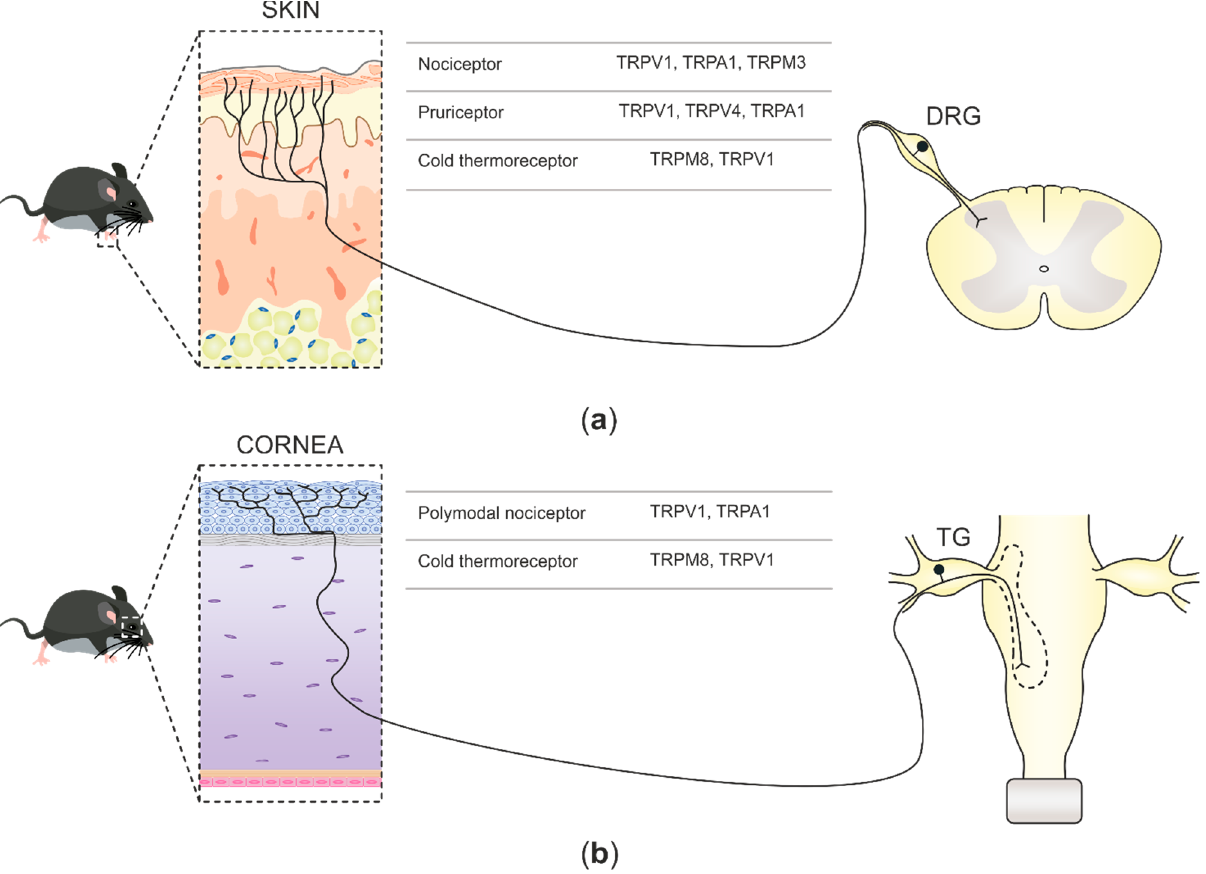
Figure 1. Schematic illustration depicting somatosensory innervation and their projections to the central nervous system (CNS). ( a ) Somatosensory nerve endings innervating the skin project to the dorsal horn second-order neurons in the spinal cord. Three functional types of sensory neurons innervating the skin are represented along with the transient receptor potential (TRP) channels expressed. ( b ) Corneal somatosensory nerve endings densely populate the corneal epithelium, reach the trigeminal ganglia (TG) through the ophthalmic nerve, and project, together with other primary nociceptive neurons innervating the face, to second-order CNS neurons at the spinal part of the trigeminal nuclei in the brainstem. Two functional forms of corneal sensory neurons and the TRP channels that they express are represented.